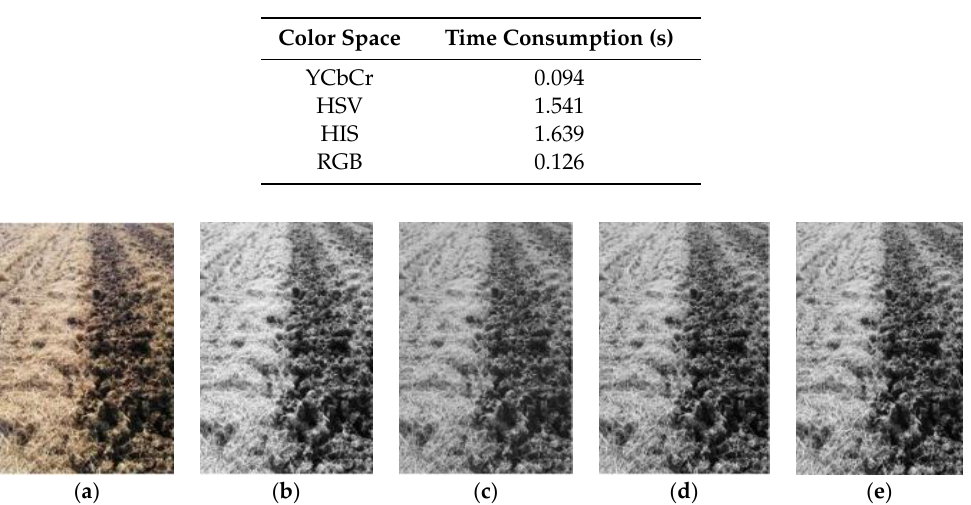
Table 1. Consumption contrast of different color spaces.